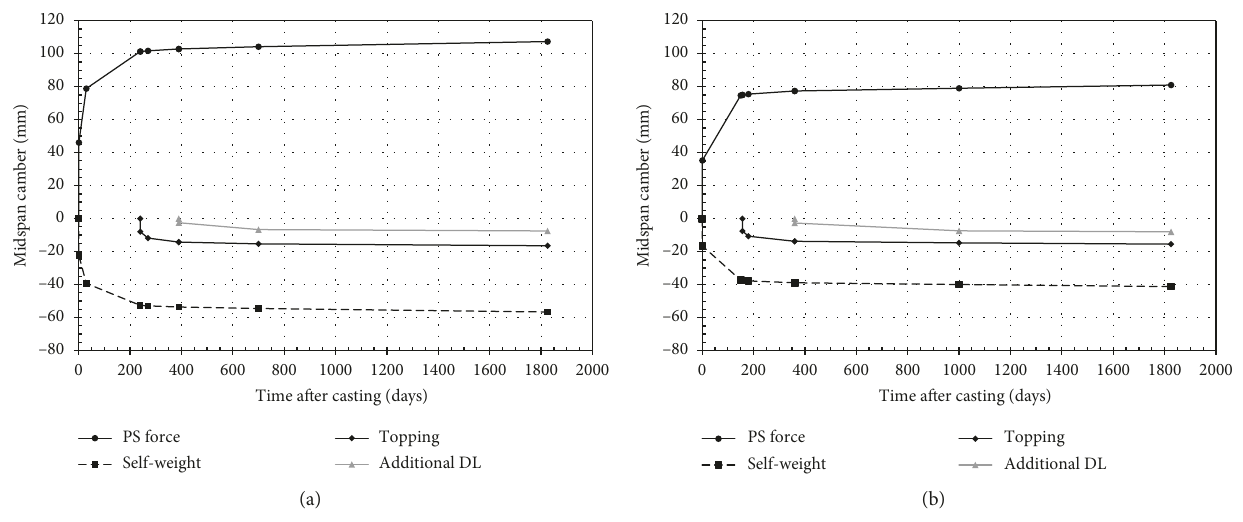
Figure 6: Predictions by the proposed multipliers for each load type. (a) Bridge A. (b) Bridge B.